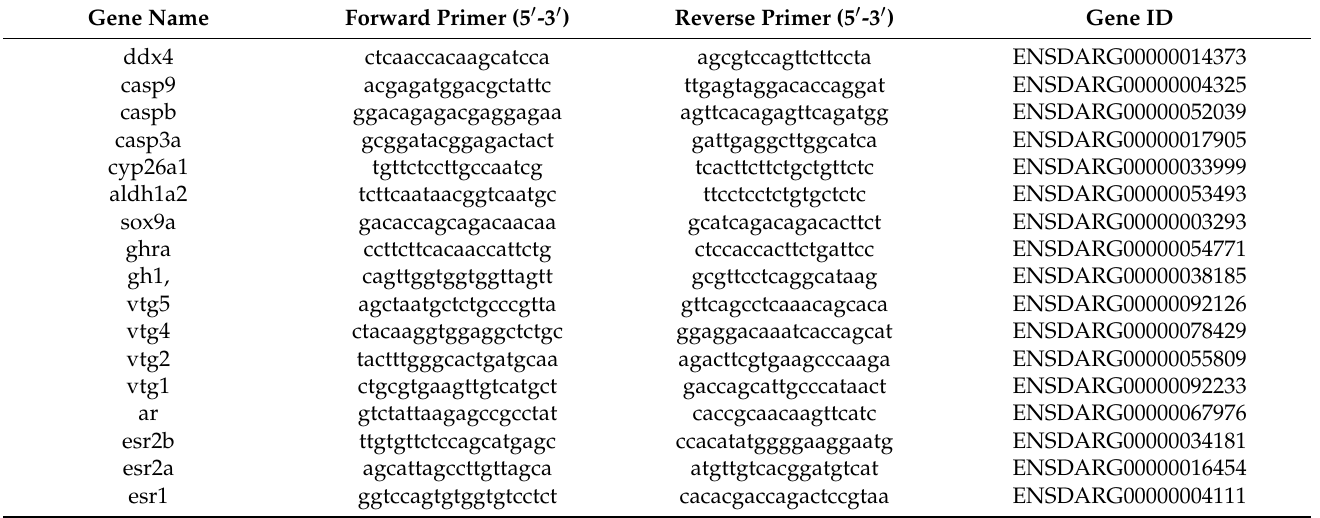
Table 1. Primer sequences for receptor-associated genes for